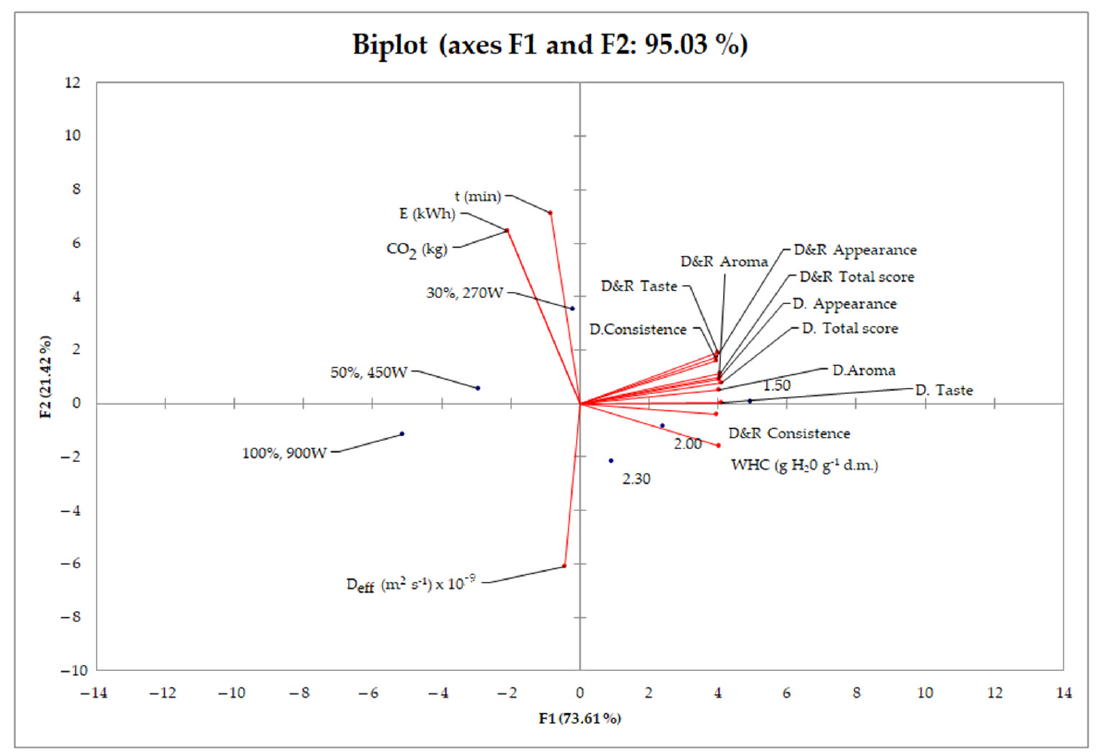
Figure 6. PCA of independent variables and responses the WHC, D eff , t, E, CO 2 , and sensory properties. The red lines are the original variables in the space of the first and second